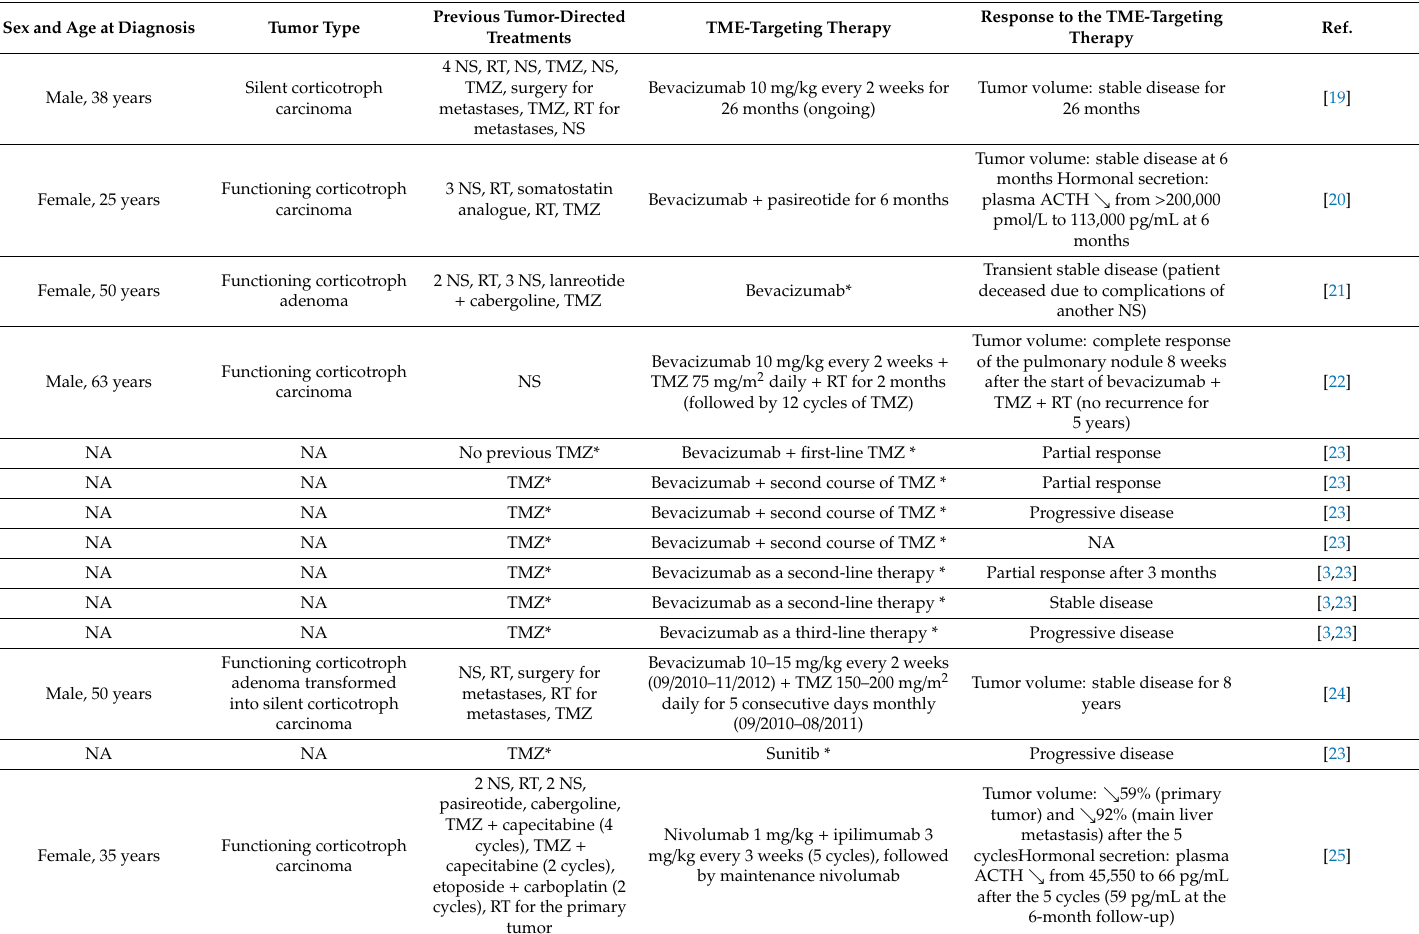
Table 1. Cases of aggressive pituitary tumors and pituitary carcinomas treated with TME-targeting